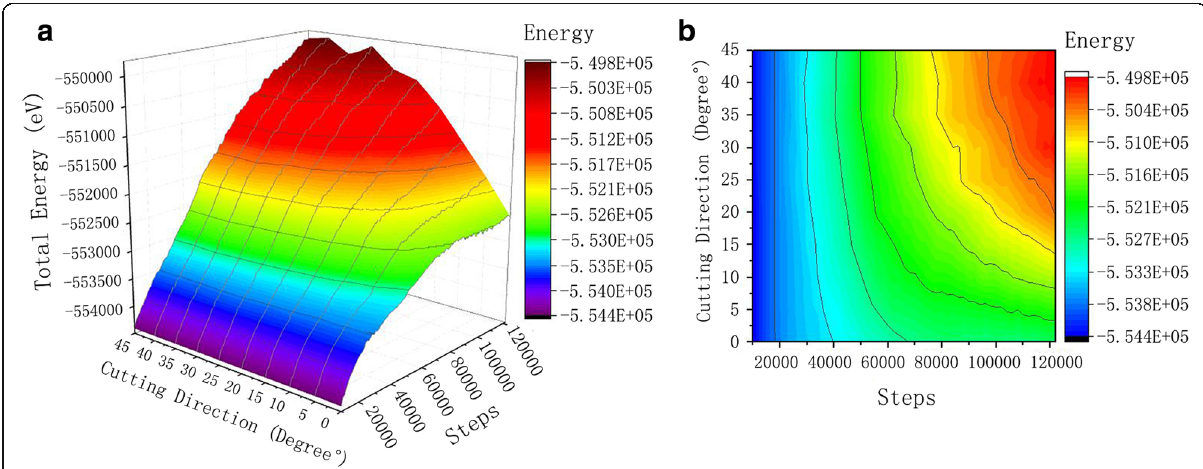
Fig. 9 Total energy curve. Figure 9 shows the total energy curve. During the process of SiC cutting the single crystal copper workpiece, the effect of the abrasive grains on the workpiece is manifested in two forms: part of which is converted into kinetic energy, the atomic heat is increased, and local kinetic energy becomes larger when polishing the joint area of the single crystal copper workpiece and the SIC particles; the other part is converted into potential energy, the internal structure of the monocrystal copper workpiece is changed, lattice is deformed, and lattice energy is released and changed into potential energy. a 3D curve. b